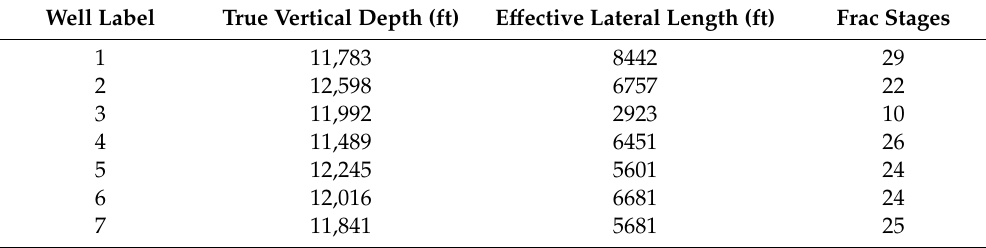
Table 1. TMS wells used in this